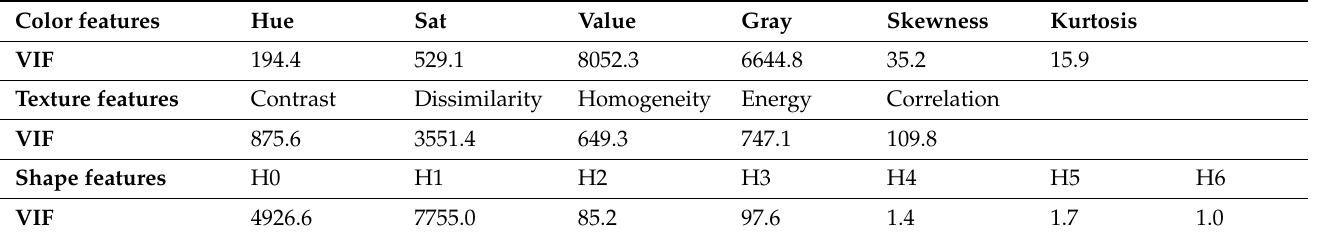
Table 4. Variance inflation factor of color, texture, and shape features extracted from soil surface